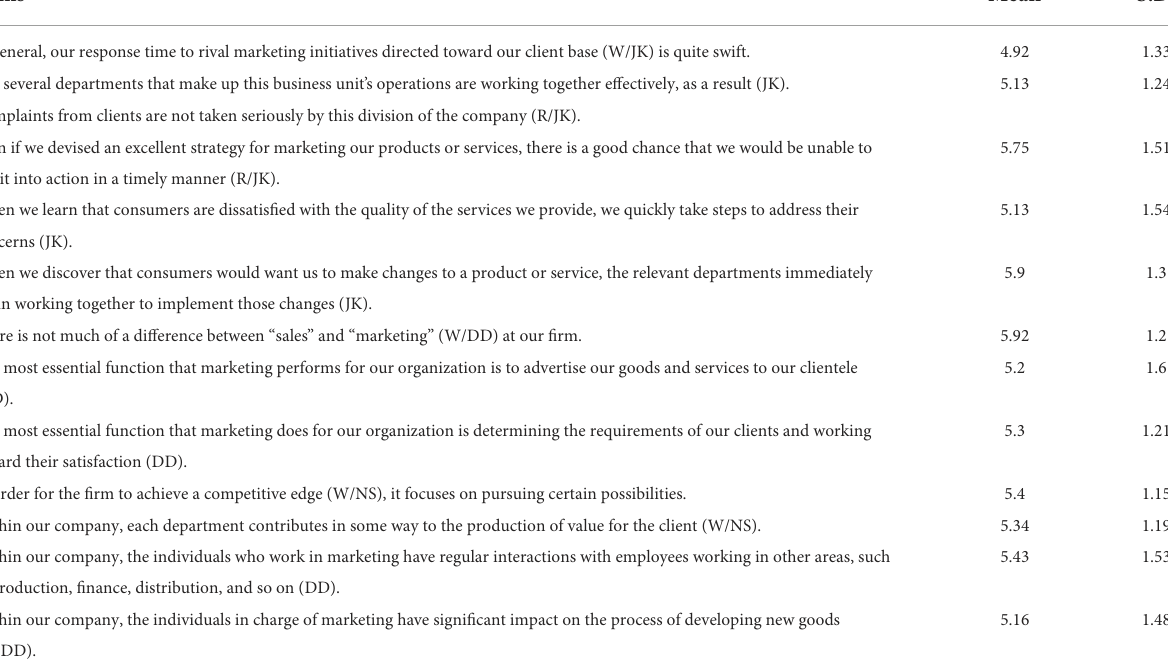
TABLE 3 Variance of the another component